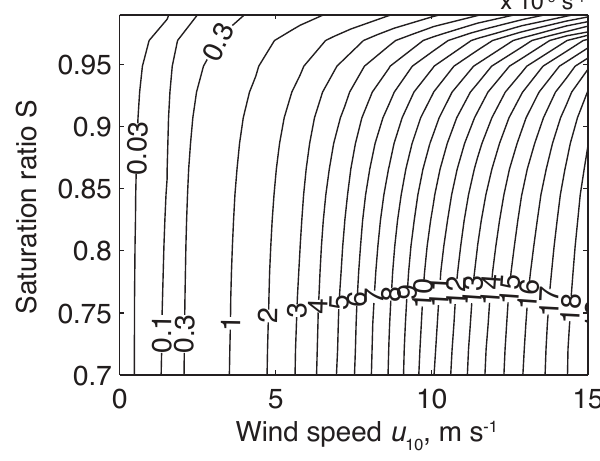
Fig. 4. Rate coefficient k , (10 − 5 s − 1 ) for gaseous Hg II uptake and deposition by sea-salt aerosol as simulated by the marine bound- ary layer model of Holmes et al. (2009) as a function of 10-m wind speed ( u 10 ) and water vapor saturation ratio ( S ). For each ( u 10 ,S ) pair we conducted 40 Monte Carlo simulations with other box model parameters varying over their likely